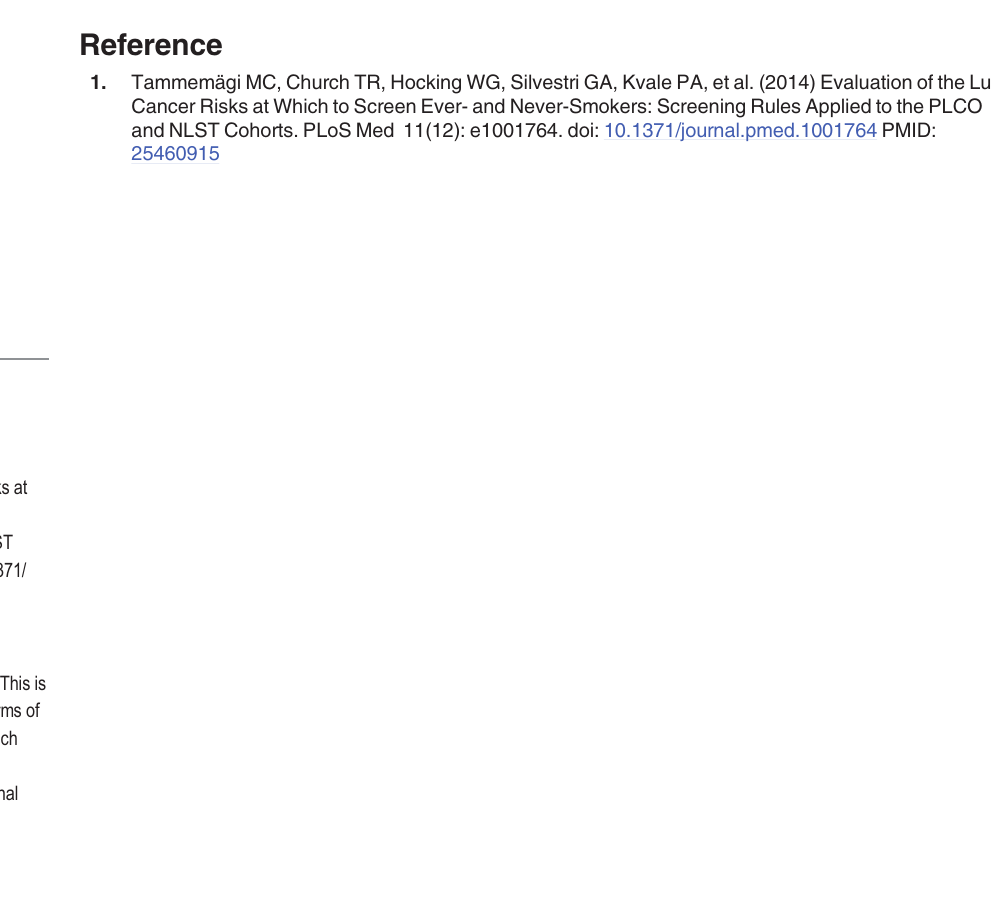
S1 Table. Risk model predictors and predictive performance statistics for the PLCOm2012 and PLCOall2014